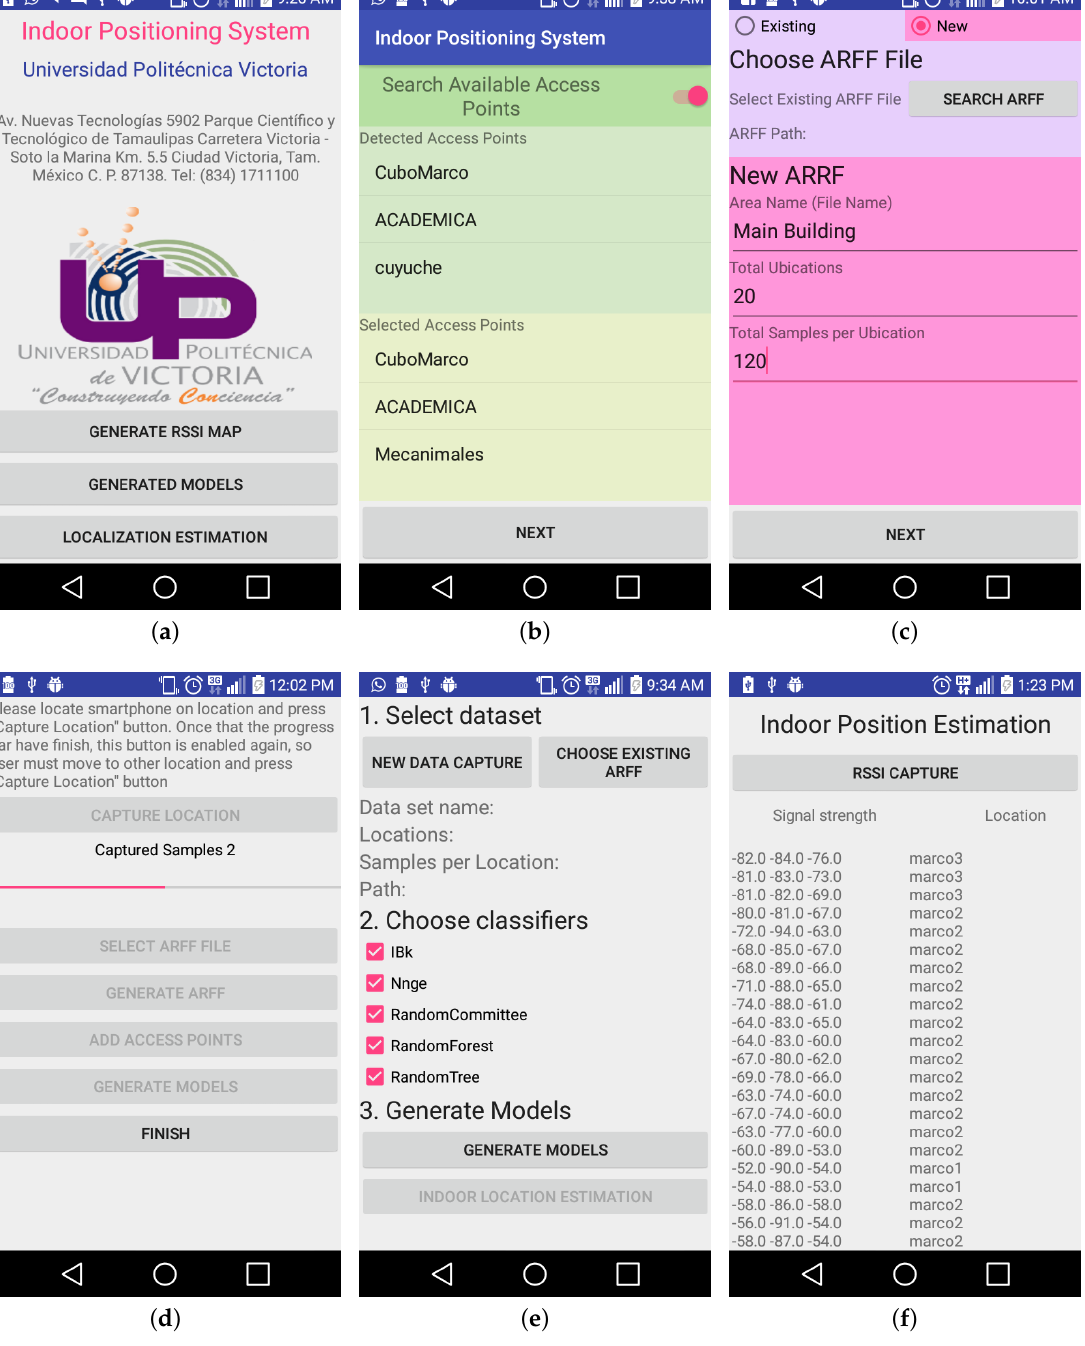
Figure 3. Screen of the proposed IPMApp application. ( a ) Main screen; ( b ) Access point selection; ( c ) Configuration of captured dataset; ( d ) RSSI signal capture; ( e ) Training of ML classifiers; ( f ) Real-time indoor position